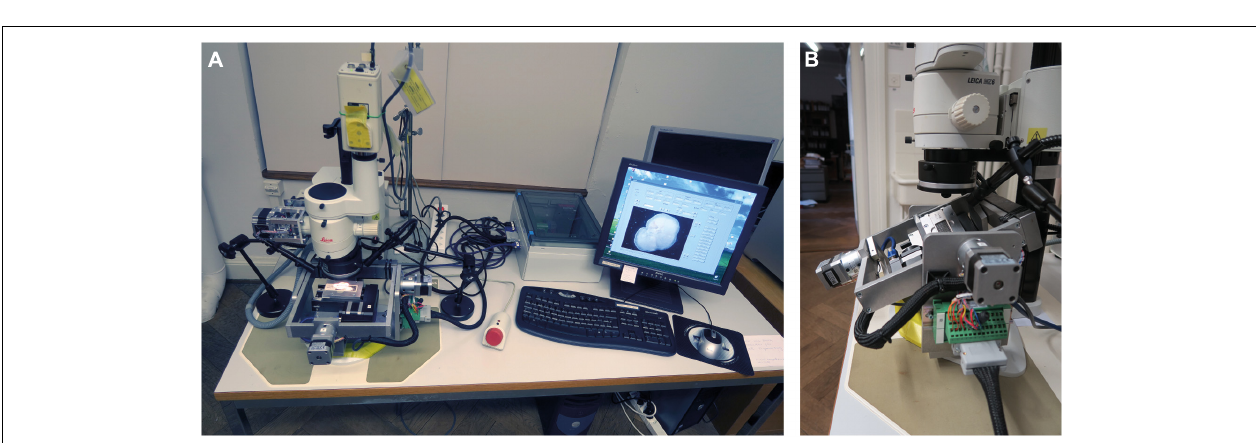
FIGURE 2 | First A utomated M easurement system for shell m OR phology (AMOR). (A) System in 2009 (an image from Knappertsbusch, 2016). (B) A motorized binocular microscope equipped with additional motor zoom and four-axis tilting stage with sample slide (an image from Knappertsbusch et al., 2009). (C) Details of a multicellular Plummer cell showing menardiforms mounted in keel position.